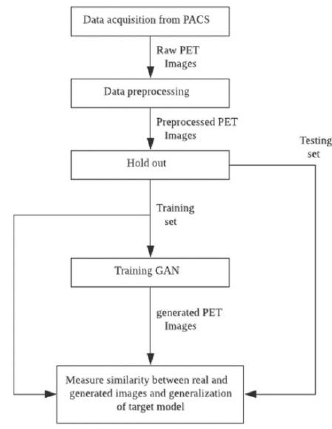
Figure 1. Data flow diagram summarizing the experimental process.